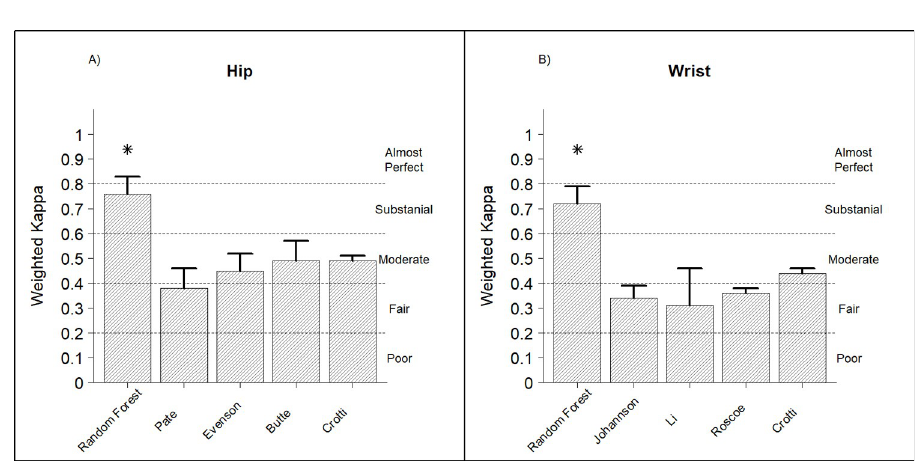
Fig 1. Kappa statistics for the random forest physical activity classifiers and cut-points. Error bars = 95% CI; Asterisk ( � ) indicates significantly different from all cut points for that placement (P < 0.05).